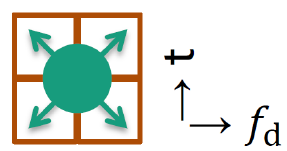
Figure 9. Range-Doppler gate straddling loss of a confined point scatterer return. The Doppler moving impact on the bandwidth-dependent f D ( f − f c ) , f ∈ [ f l , f u ]